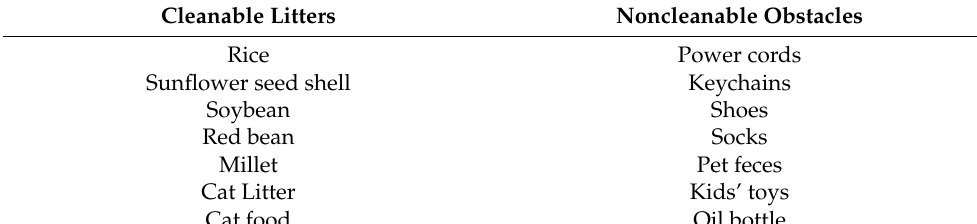
Table 4. Examples of indoor cleanable litters and noncleanable obstacles in our dataset.